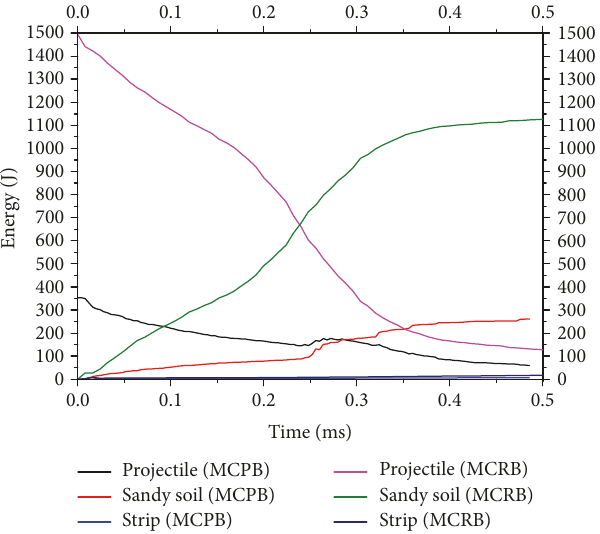
Figure 25: Energy transfer during the